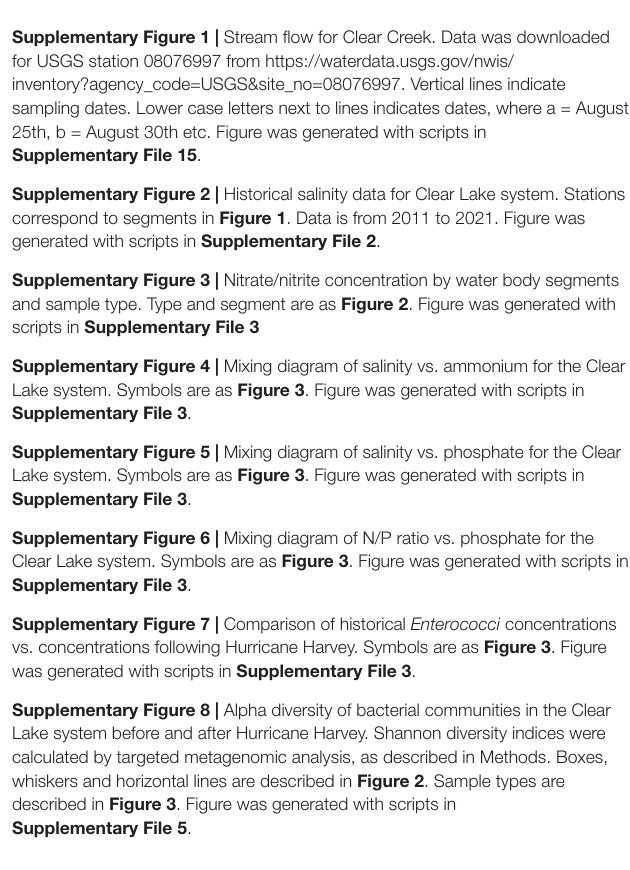
Supplementary Figure 2 | Historical salinity data for Clear Lake system. Stations correspond to segments in Figure 1 . Data is from 2011 to 2021. Figure was generated with scripts in Supplementary File 2 . Supplementary Figure 3 | Nitrate/nitrite concentration by water body segments and sample type. Type and segment are as Figure 2 . Figure was generated with